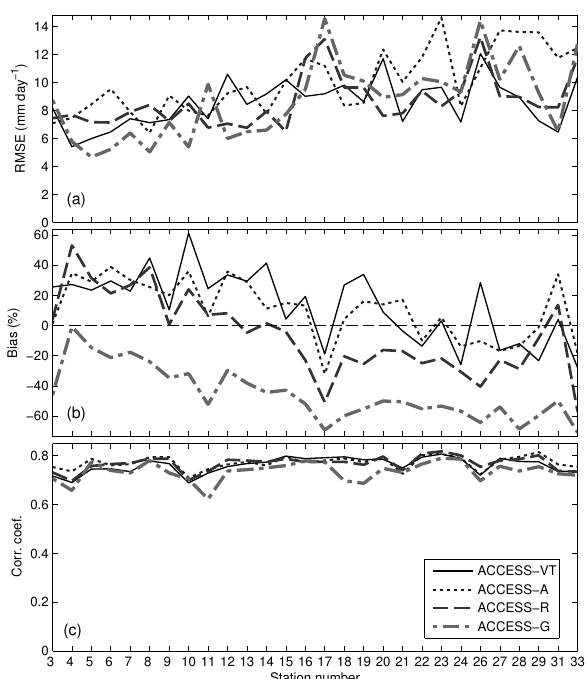
Fig. 5. Evaluation scores of the ACCESS models for daily precipita- tion forecast at stations: (a) RMSE, (b) bias, and (c) Spearman rank correlation. Stations are ordered according to latitude then longi-